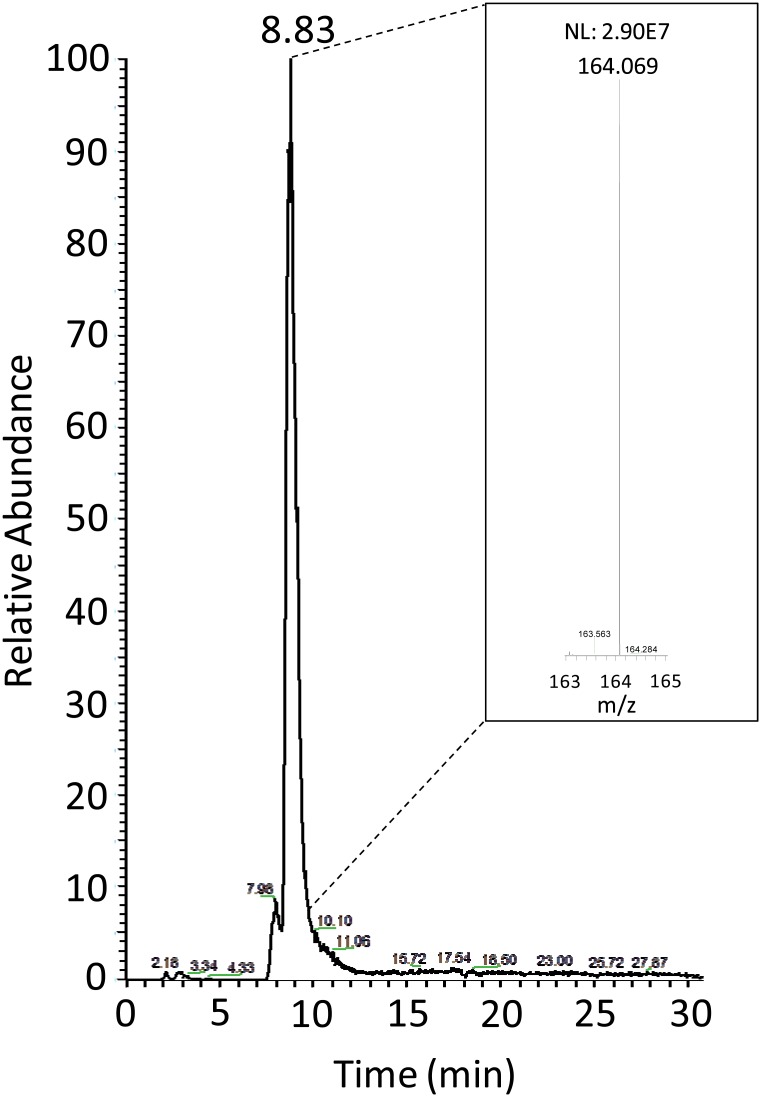
Mass spectrometry analysis of hydrolyzed p-ACA/matrix.The eXtracted Ion Current (XIC) profile at 164.069 m/z, recorded during the LC-MS run, is shown. LC retention time on main peak is evidenced. The 164.069 m/z ion corresponds (ΔM = 0.002 Da) to the theoretical m/z value of the [M+H]+ of p-ACA. NL: normalization level.